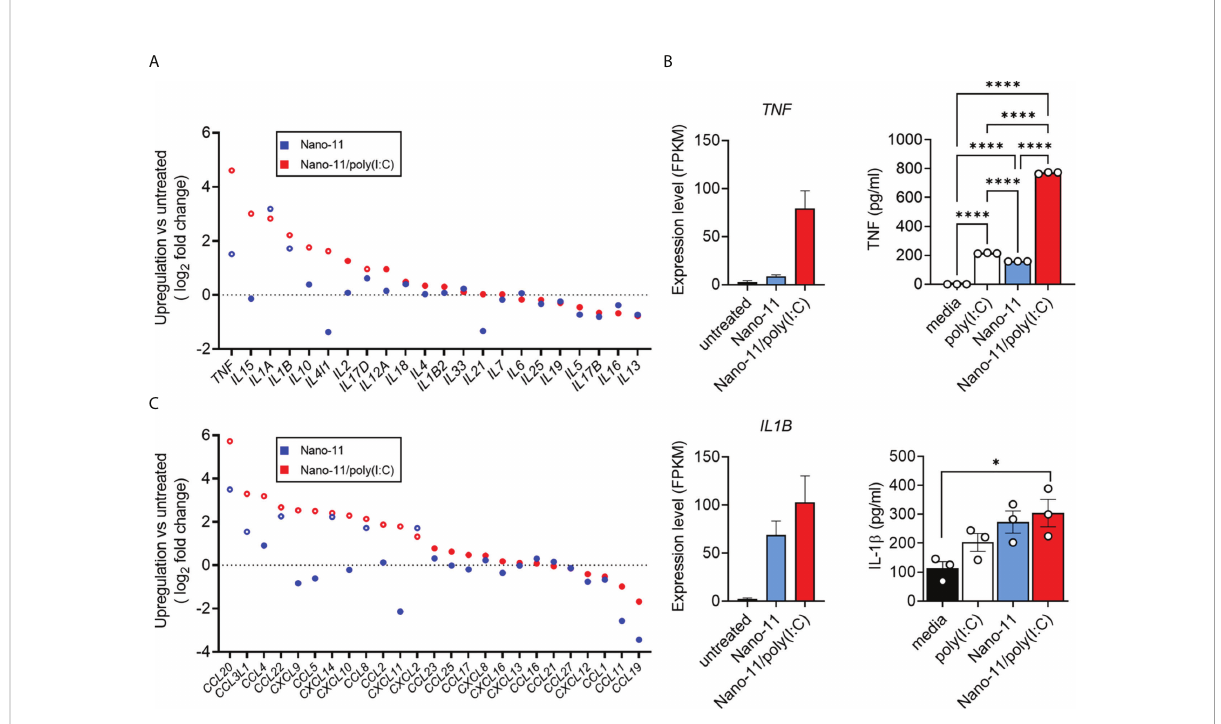
FIGURE 5 Cytokine production and expression by porcine Mo-DCs following stimulation with Nano-11 or Nano-11/poly(I:C). (A) Fold change of expression of cytokine-related genes. (B) Gene expression level of TNF and IL1B from three different animals represented by FPKM (fragments per kilobase of transcript sequence per millions base pairs sequenced). The supernatants of porcine Mo-DCs stimulated with Nano-11 ± poly(I:C) or left unstimulated as control were tested for TNF and IL-1 b by ELISA. The bars indicate the mean ± SE of three replicates. Results are representative of two independent experiments. *p < 0.05, ****p < 0.0001 by one-way ANOVA with Tukey multiple comparisons test. (C) Fold change of expression of chemokine-related genes. Each circle represents the mean of Mo-DCs isolated from three different animals. Genes with signi fi cant mRNA upregulation (p < 0.05) are represented by open circles. The dashed line indicates no change in